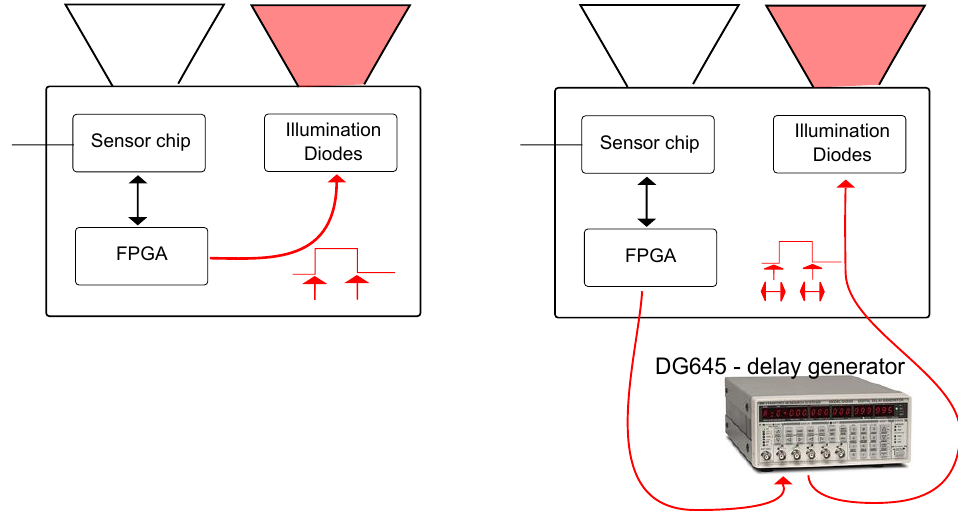
Figure 12. Modifying the prototype camera using an external Delay